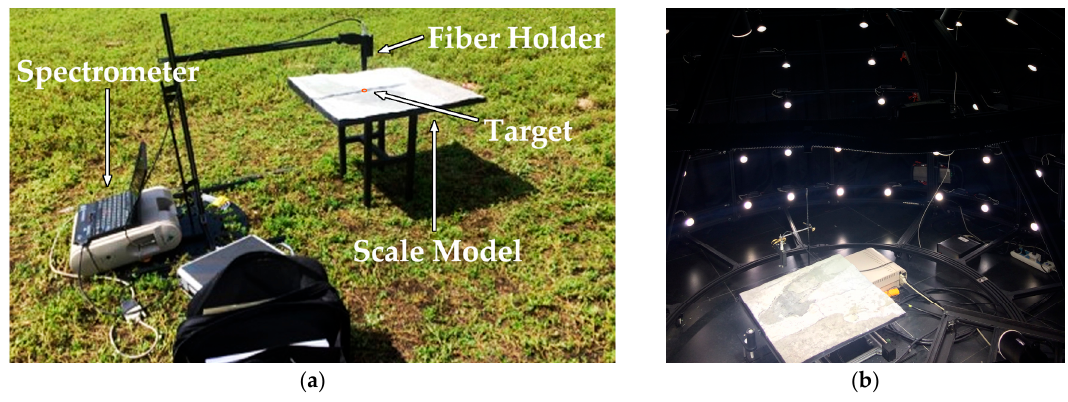
Figure 10. Photographs of the experiment: ( a ) collecting the reflected radiance of the target in the field and ( b ) collecting the reflected radiance in the skylight simulator.